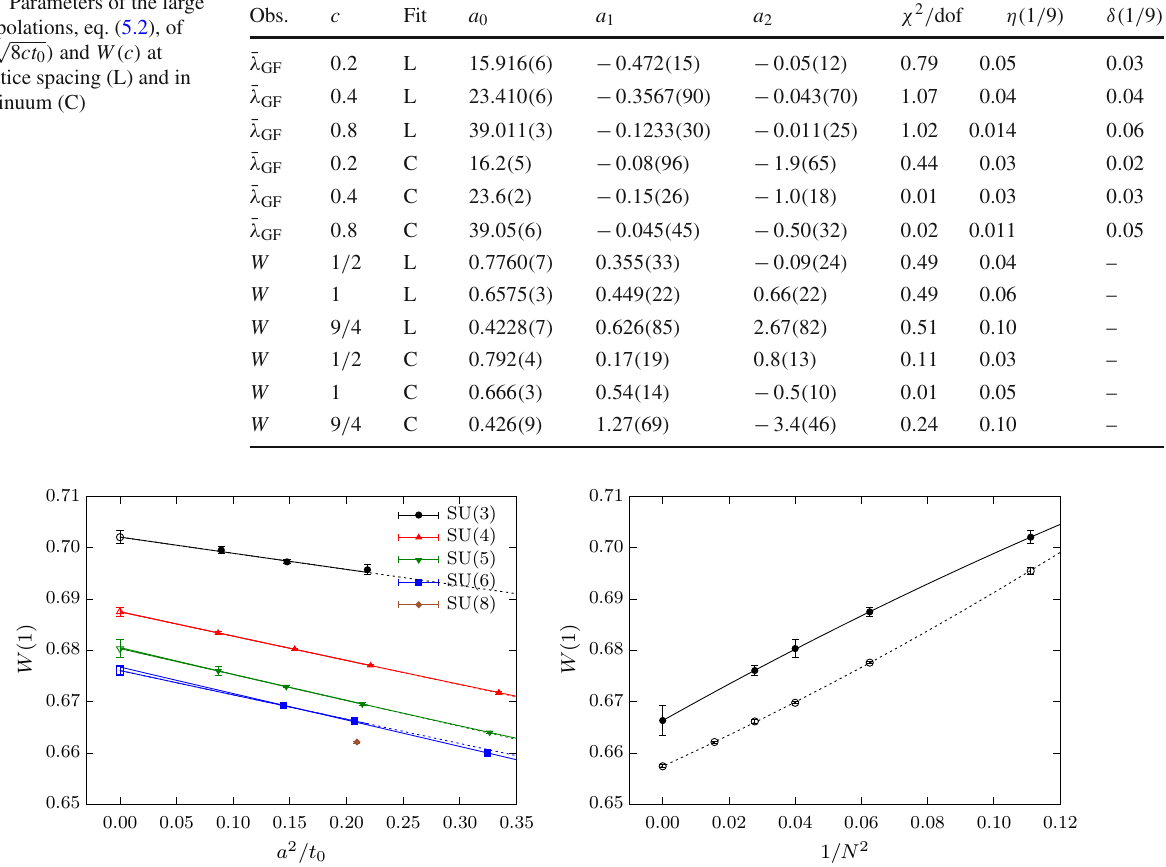
Fig. 5 Left: Continuum extrapolation of W ( 1 ) for all gauge groups. Right: Large N extrapolations of W ( 1 ) in the continuum (solid line) and at finite lattice spacing (dotted line). There is an excellent agree-